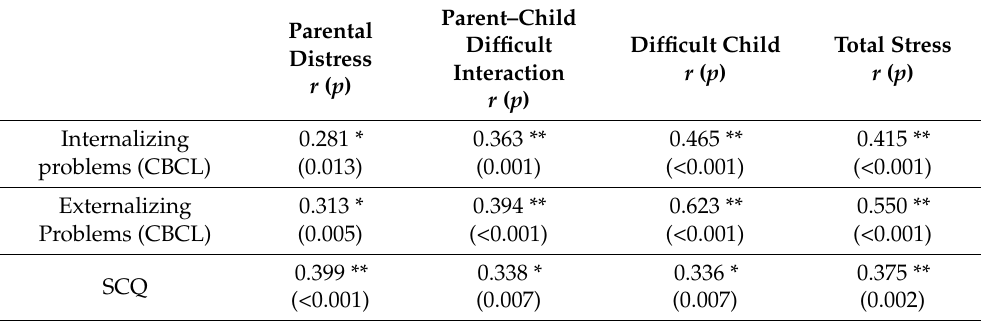
Table 1. Association between maternal stress and child emotional and behavioral